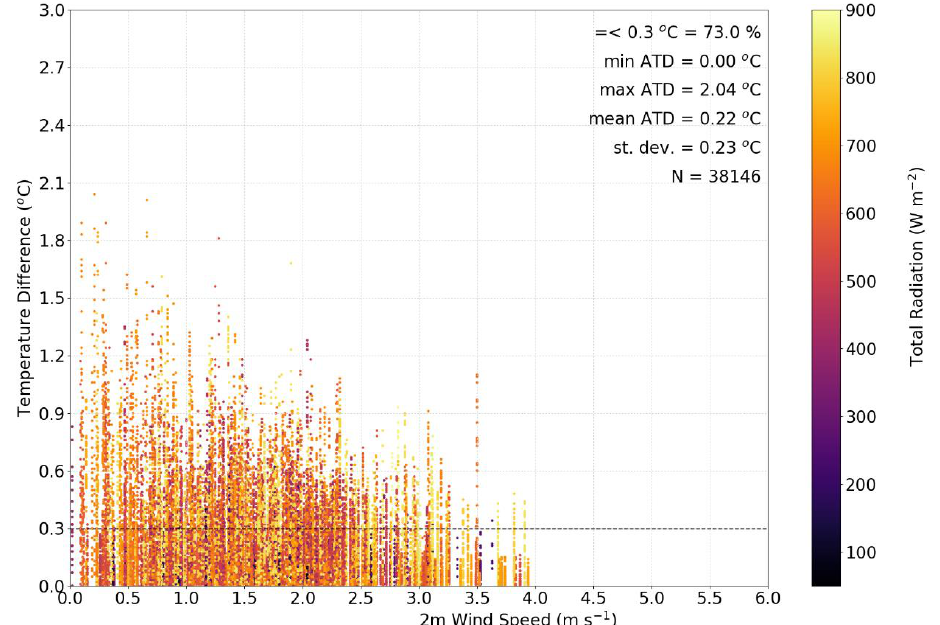
Figure 5. Absolute temperature difference (°C) of all iMET-XQ pairs on all experiment days by 2 m wind speed (m s −1 , x-axis) and solar radiation (color), for the daytime Tower experiments (i.e., dusk experiments excluded).